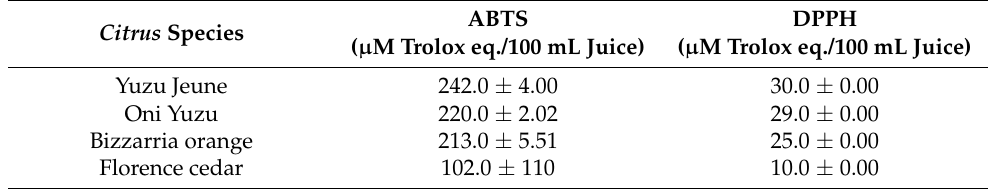
Table 3. Antiradical activity of citrus